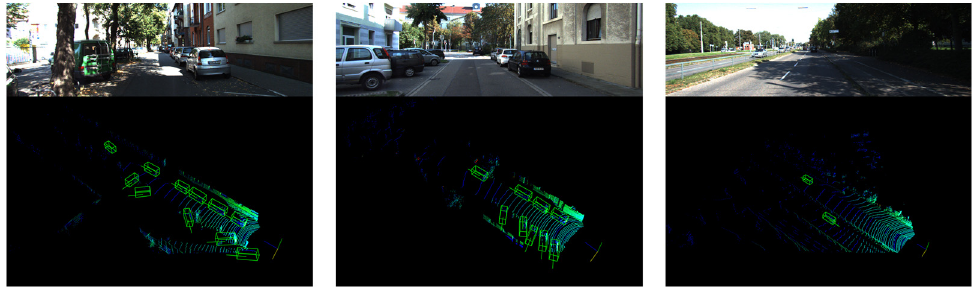
Figure 7. The base detection results from PointRCNN.